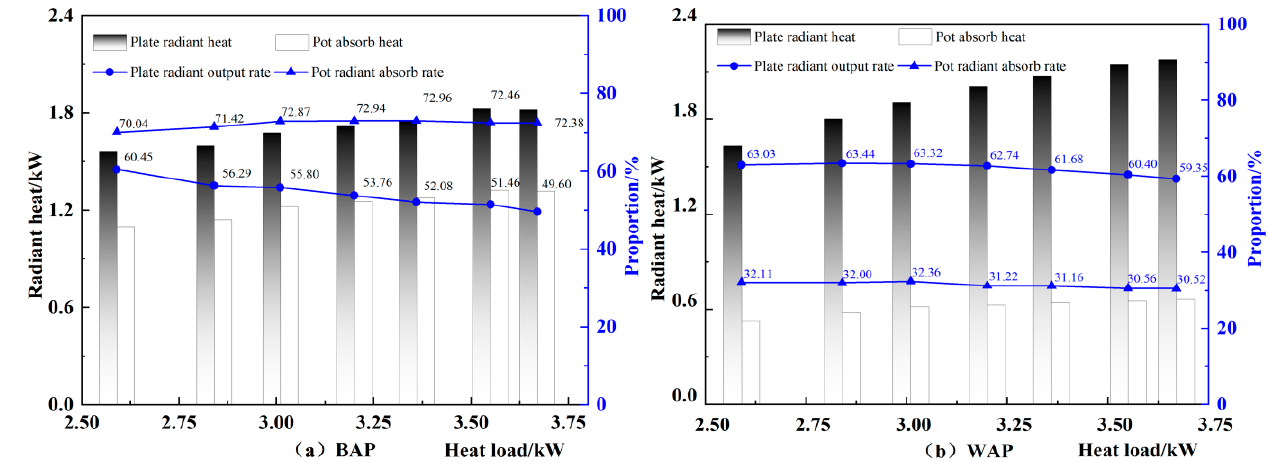
Figure 6. Radiant heat of PCP under different heat loads.